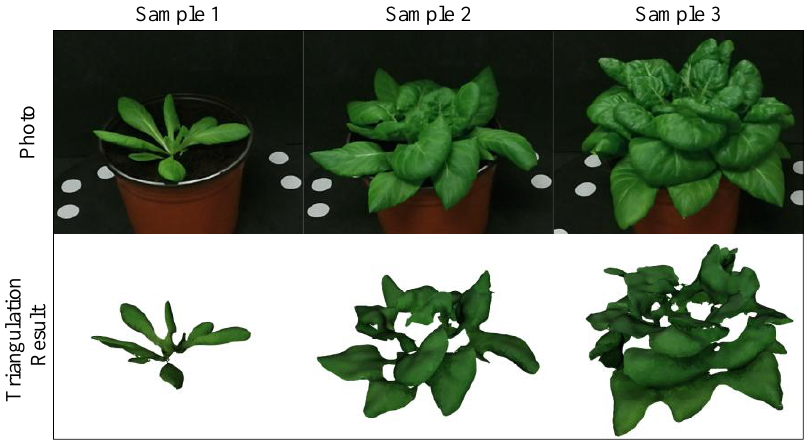
Figure 12. Triangulation results of plants in different sizes. The triangular meshes can be found in Supplementary Material C.